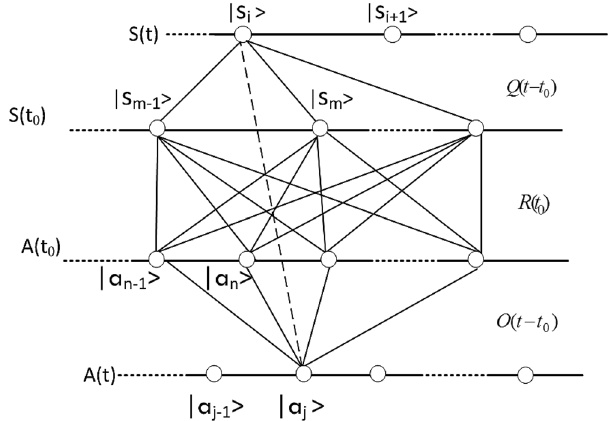
Figure 2. Time evolution of probability